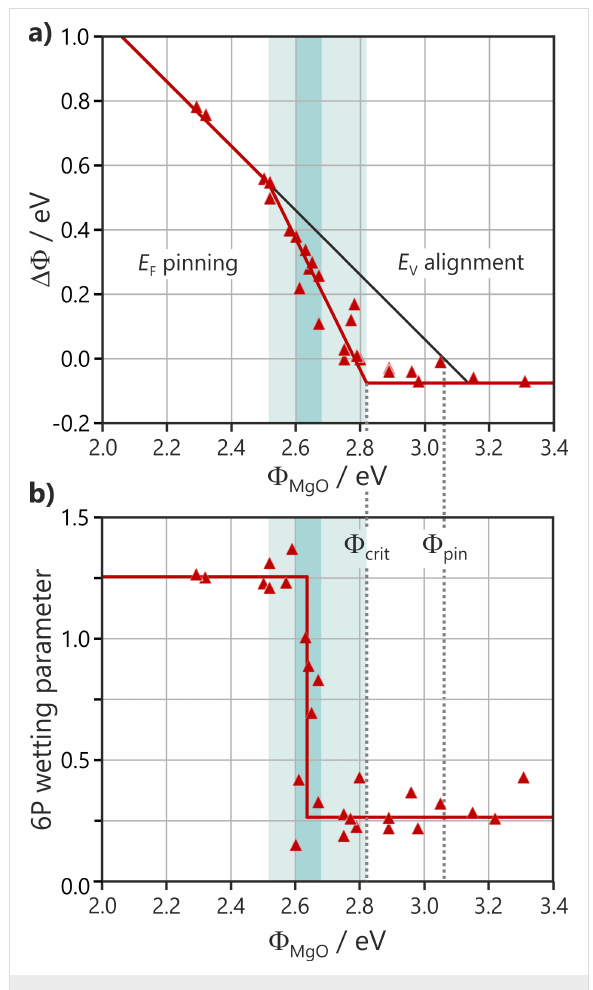
Figure 8: Changes in the charge transfer and wetting behavior of 6P on MgO(100)/Ag(100) as a function of Φ MgO . (a) Work function change induced by 6P as an indicator of charge transfer. The black 45° line corresponds to a constant final work function and expresses the be- havior when Φ pin = Φ crit . (b) Wetting parameter as an indicator of the fraction of the substrate covered by 6P.